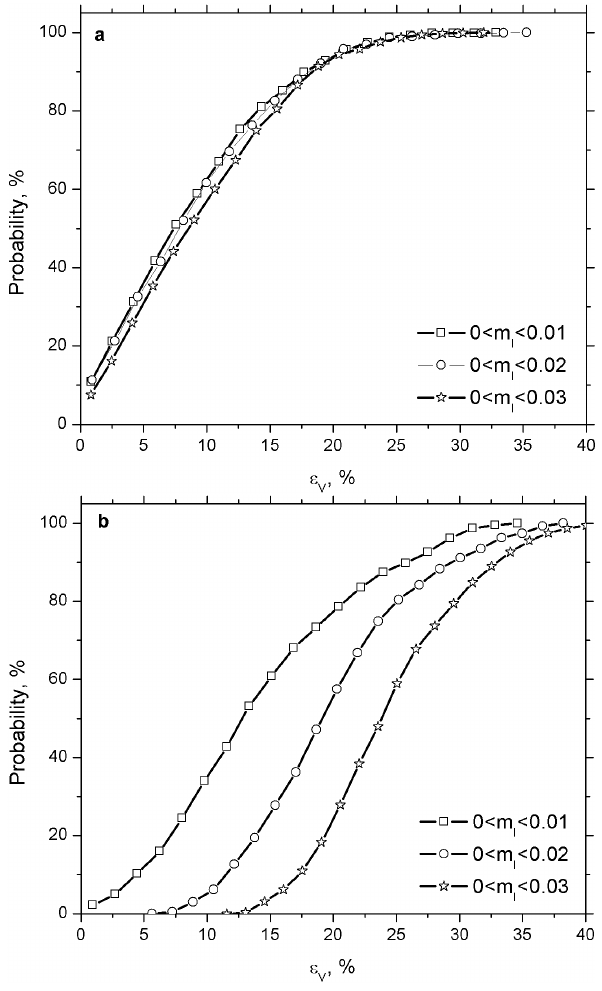
Fig. 3. Uncertainty of particle volume estimation for different ranges of considered m I : [0, 0.01], [0, 0.02], [0, 0.03]. Simula- tion was performed for distribution d V with (a) r 0 =0.2µm and dln r (b) r 0 =2µm. Input errors are ε =10% and model refractive index m =1.45– i